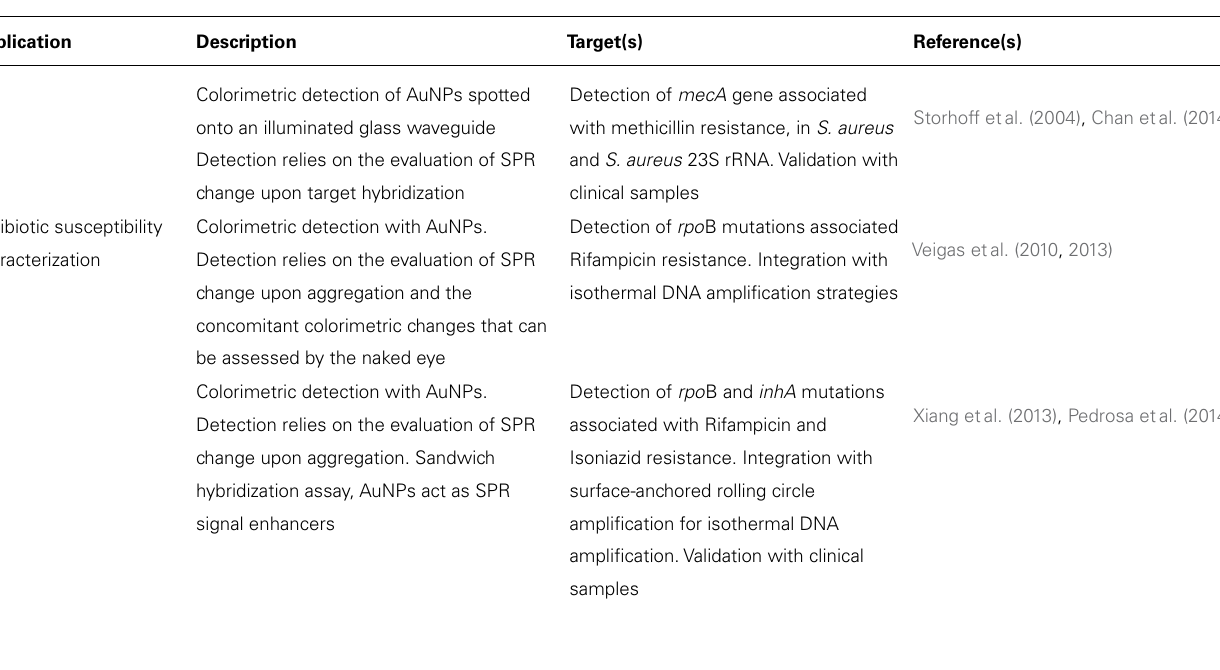
Table 1 |AuNPs-based systems for pathogen antibiotic susceptibility characterization.